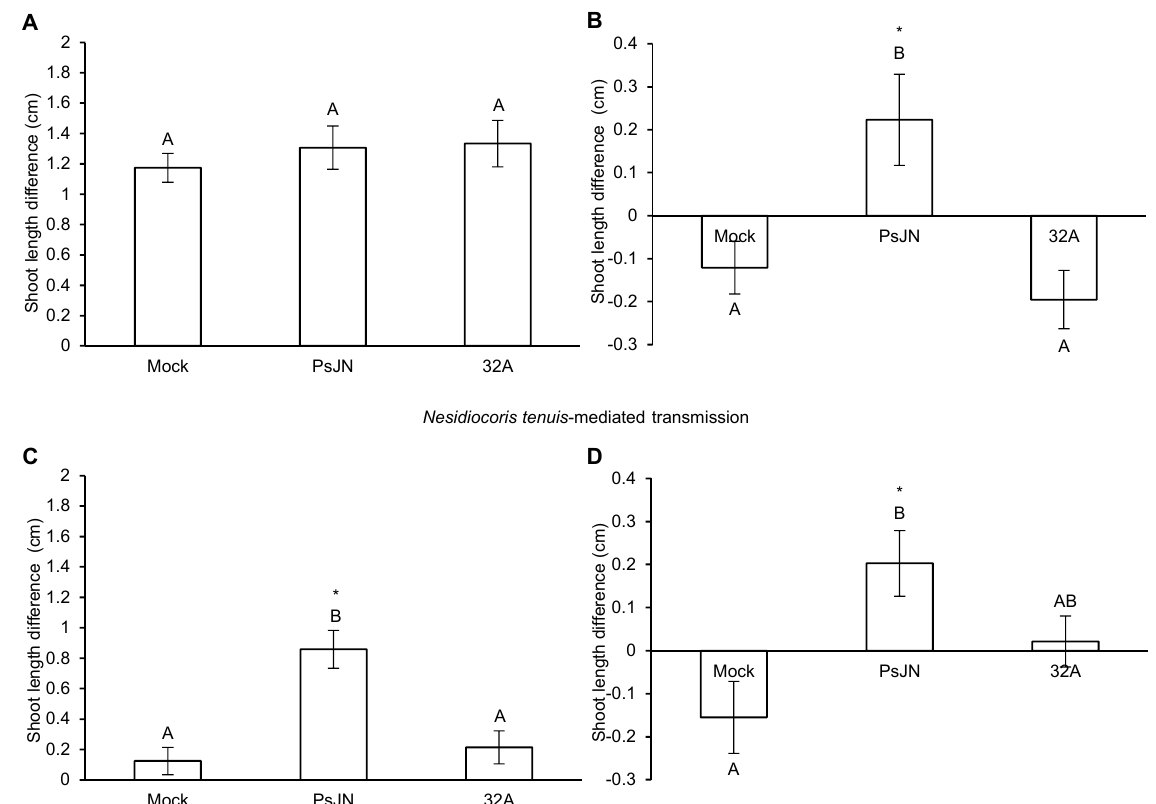
Figure 5. Effects of mirid feeding on tomato shoot length. Changes in shoot length caused by Macrolophus pygmaeus ( A , B ) or Nesidiocoris tenuis ( C , D ) feeding were assessed on mock-inoculated plants (Mock) and plants inoculated with Paraburkholderia phytofirmans PsJN (PsJN) or Enterobacter sp. 32A (32A) and calculated as the difference between the shoot length measured before (Day 7) and after (Day 11) the acquisition period ( A , C ), or before (Day 11) and after (Day 14) the mirid-mediated transmission ( B , D ). The two-way analysis of variance showed no significant differences between the two experimental repetitions ( p > 0.05) and data from the two experiments were pooled. Mean and standard error values for positive samples and at least nine replicates (plants) are presented for each treatment. Different letters indicate significant differences among treatments according to Tukey’s test ( p ≤ 0.05). Asterisks indicate significant differences in the pairwise comparisons between the mock-inoculated and bacterium-inoculated plants, according to Student’s t -test ( p ≤ 0.05).